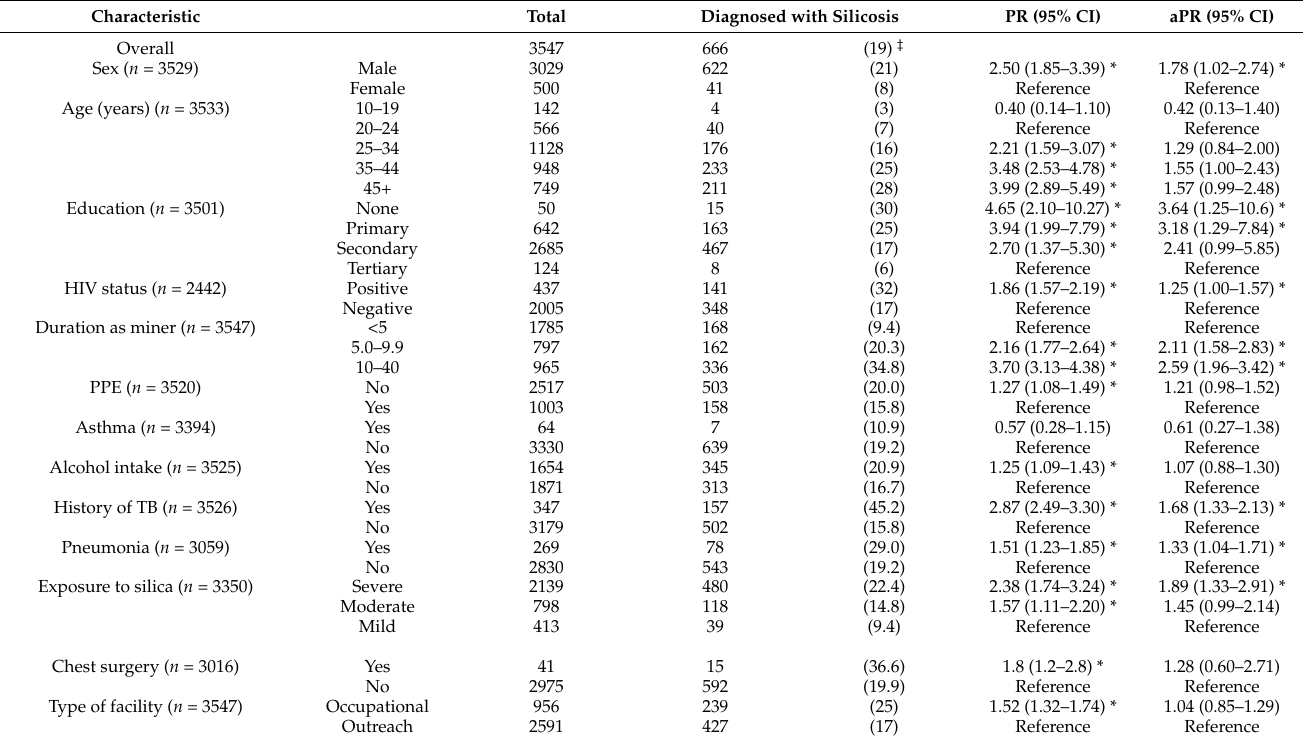
Table 3. Factors associated with diagnosis of